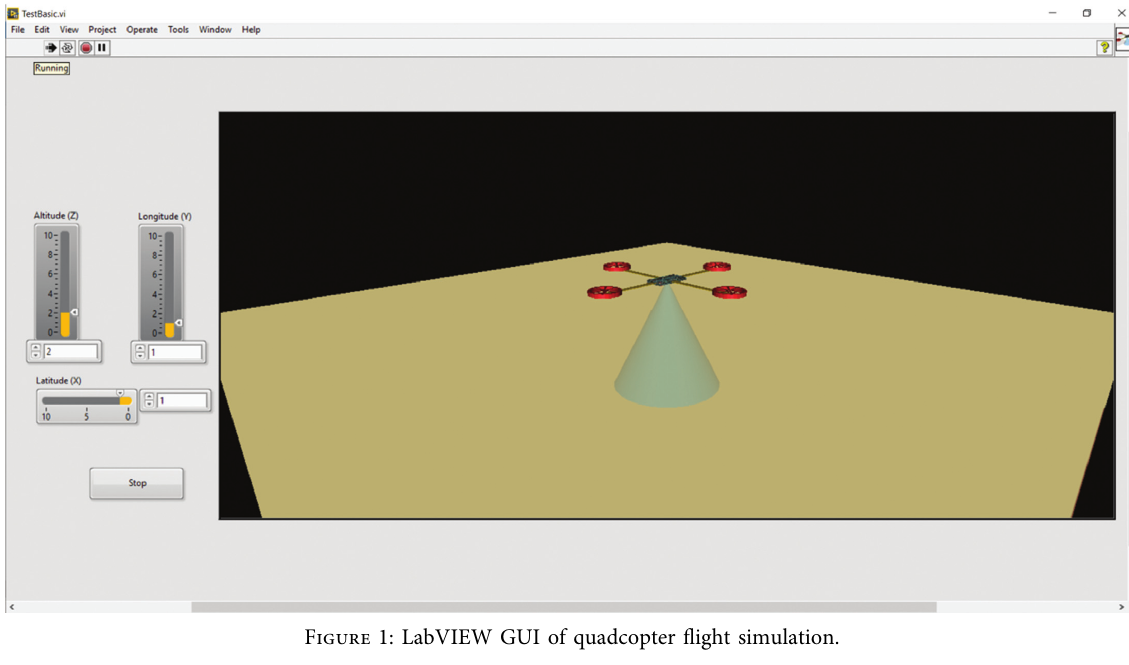
Figure 1: LabVIEW GUI of quadcopter flight simulation.